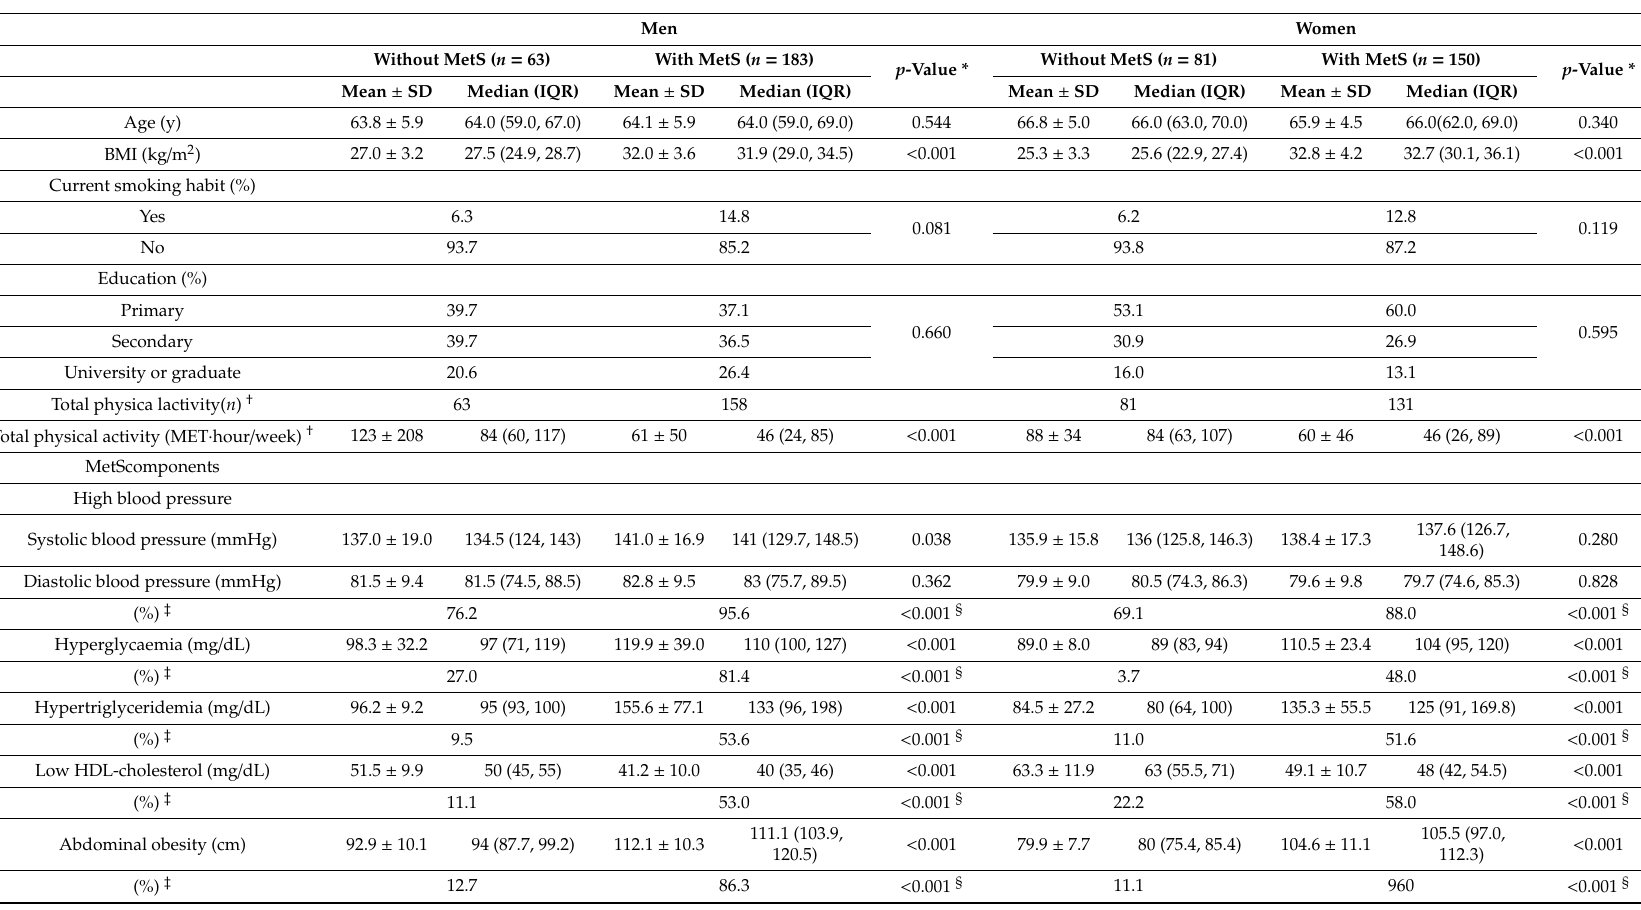
Table 1. Socioeconomicand lifestyle characteristics of participants “with Metabolic Syndrome” ( n = 333) and “without Metabolic Syndrome” ( n = 144) stratified by sex. Men